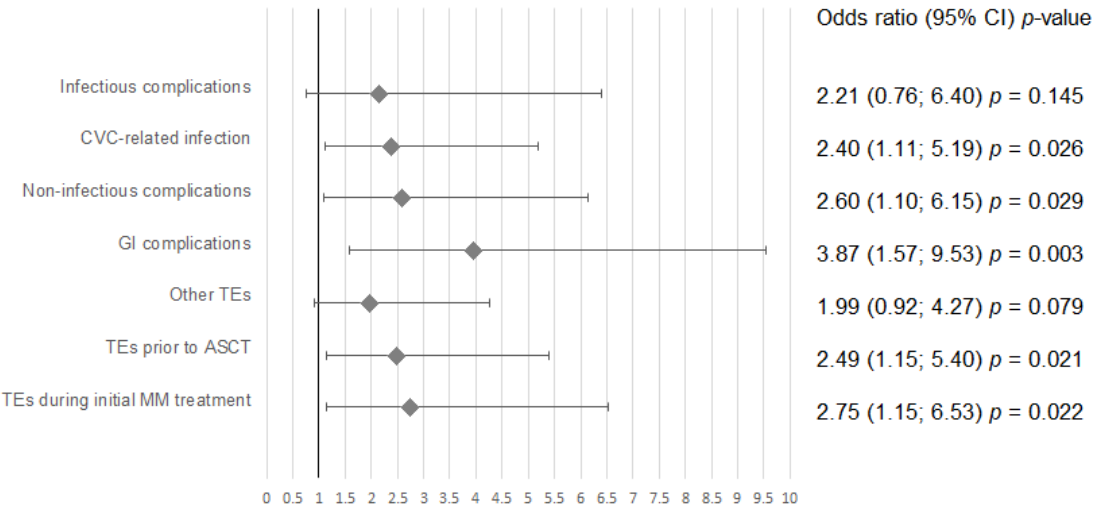
Figure 1. Univariate analysis for risk factors of catheter-related thrombosis. Abbreviations: CVC—central venous catheter, GI– gastrointestinal, TE– thromboembolic event, ASCT—autologous stem cell transplantation, MM—multiple myeloma.